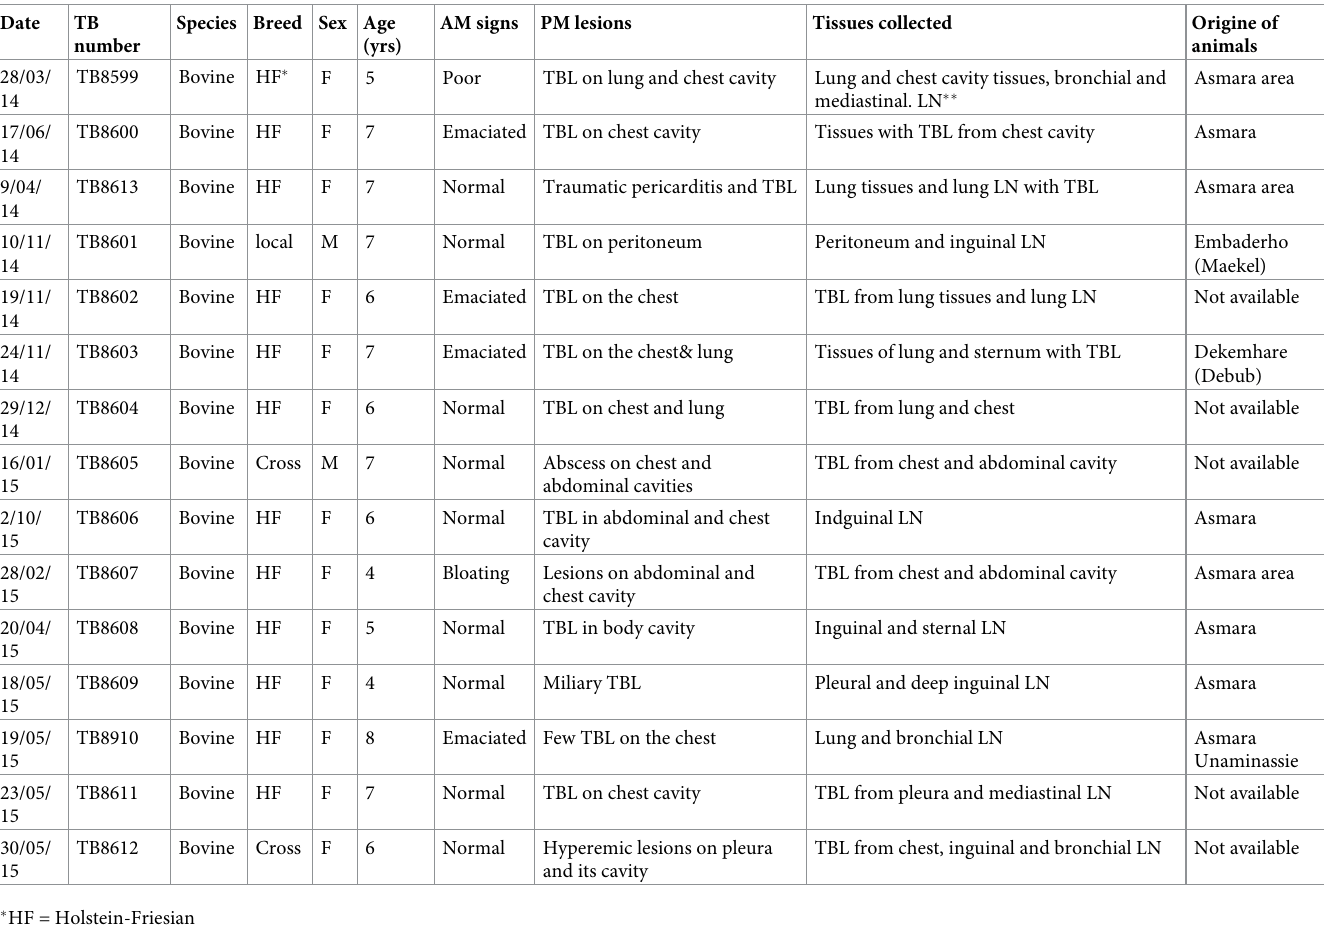
Table 1. Tissues with tuberculosis-like lesions (TBL) collected at the Asmara slaughterhouse, animals’ characteristics, ante mortem signs (AM signs), post mortem signs (PM signs), and origin of the slaughtered